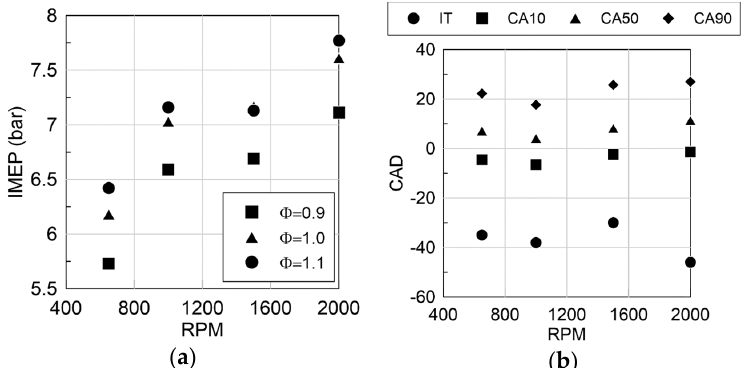
Figure 3. IMEP ( a ) and combustion phasing ( b ) vs engine speed at P in = 1 bar and 10% H 2 ( ϕ =1). 1500 rpm from [23].